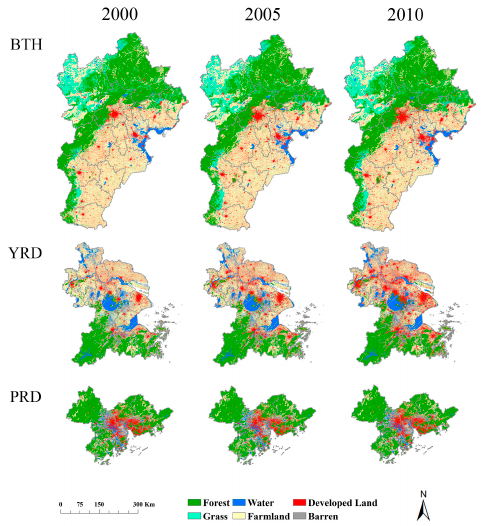
Figure 2. LULC classification maps of the Beijing-Tianjin-Hebei (BTH), Yangtze River Delta (YRD) and Pearl River Delta (PRD) urban megaregions in 2000, 2005 and 2010.